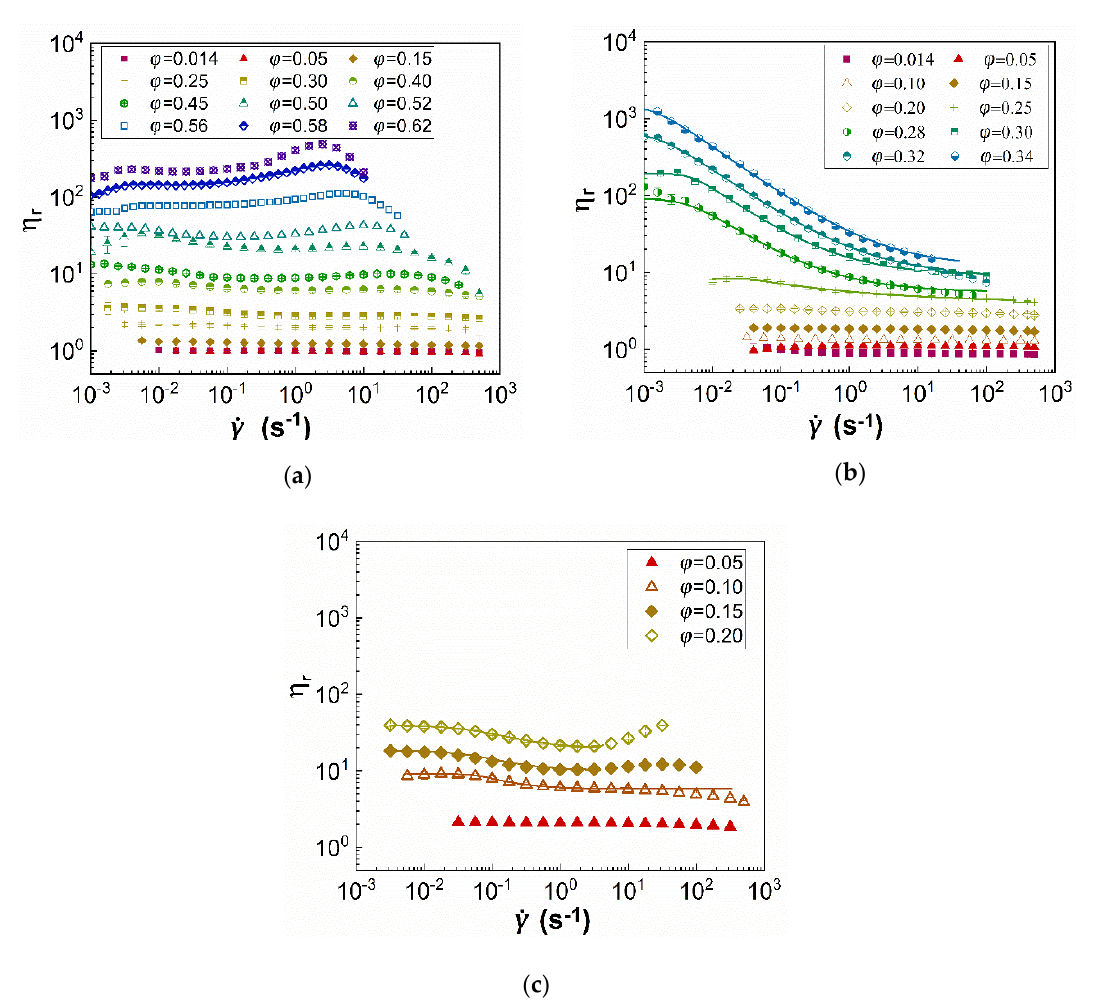
Figure 2. Relative viscosity ( η r ) of ( a ) GS2; ( b ) PS52; and ( c ) PS226 suspensions in glycerol as a function of shear rate ( ) and particle volume fraction ( ϕ ). Continuous lines correspond to the Carreau fittings to the data.